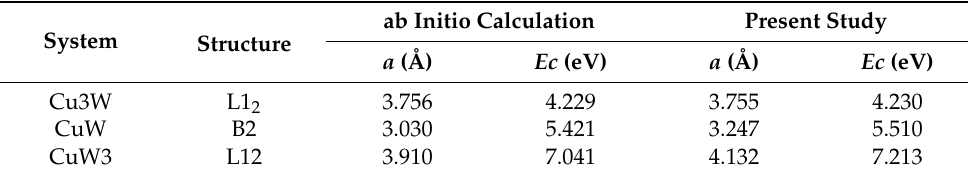
Table 3. Lattice constant a (Å) and cohesive energy Ec (eV) of two fictitious solid solutions calculated through the MD method based on the new W-Cu potential and ab initio